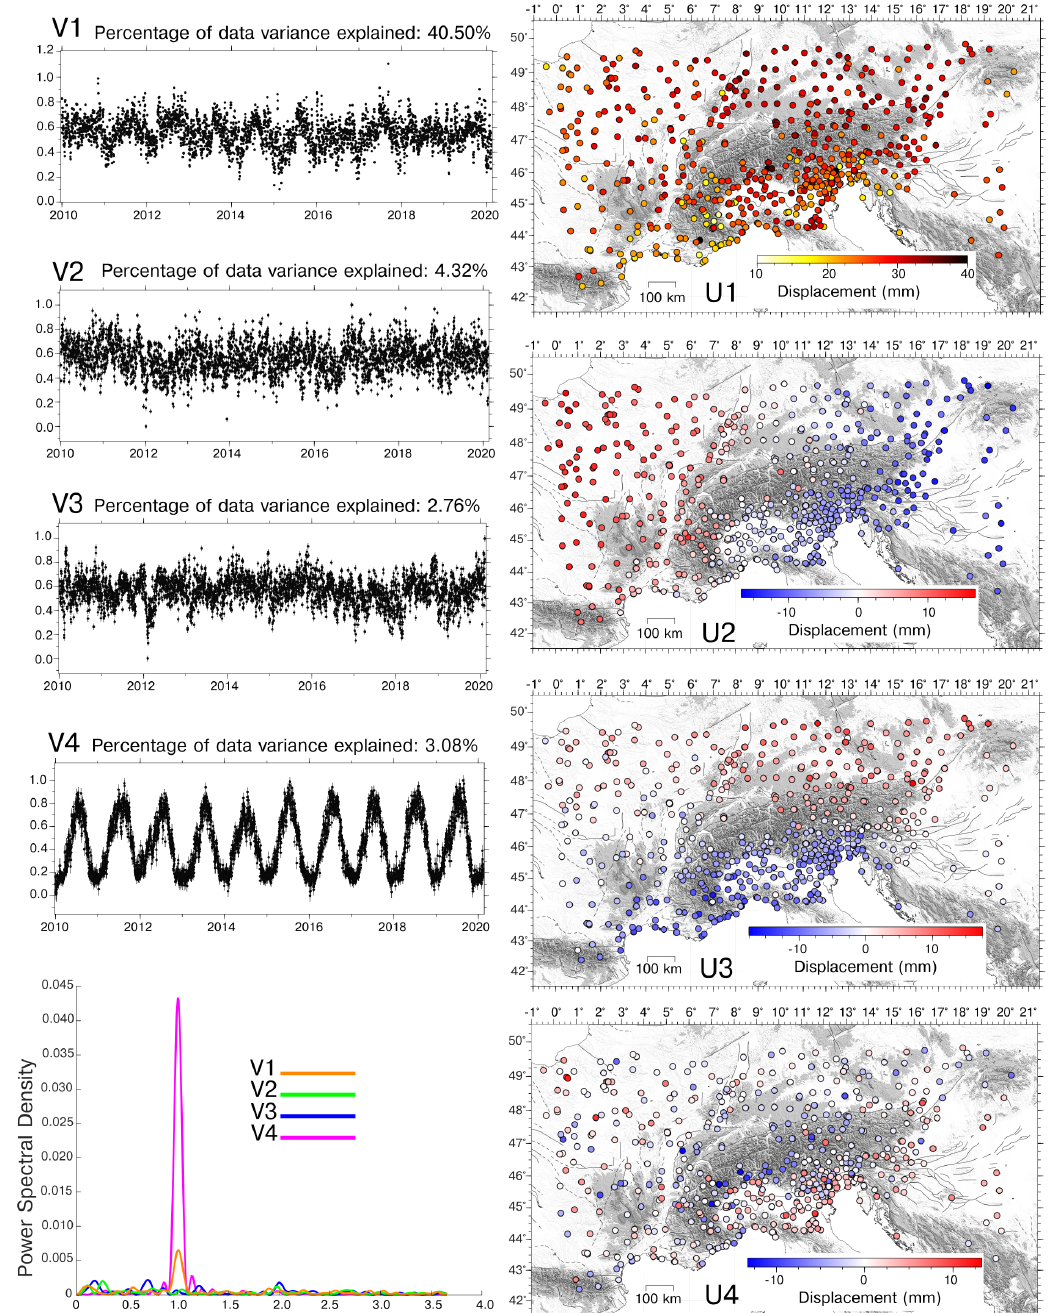
Figure 3. Temporal evolution, power spectral density and spatial response of (a) IC1, (b) IC2, (c) IC3 and (d)